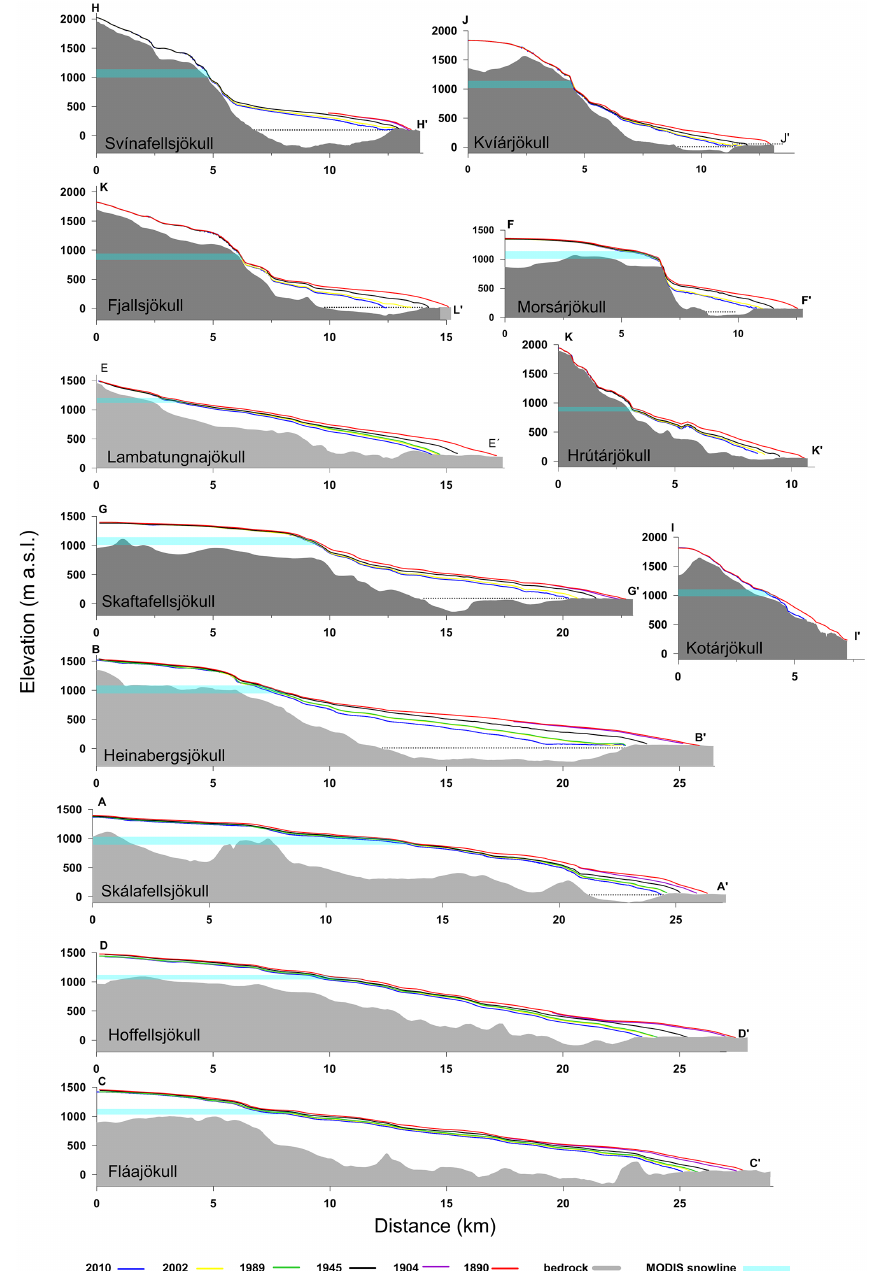
Figure 7. Longitudinal profiles of the southeast outlet glaciers, showing ice thickness and location of the termini at different times. The average ELA derived from the MODIS images is shown with a light blue horizontal line. Öræfajökull outlets with dark grey coloured basal topography and the eastern outlets with light grey coloured basal